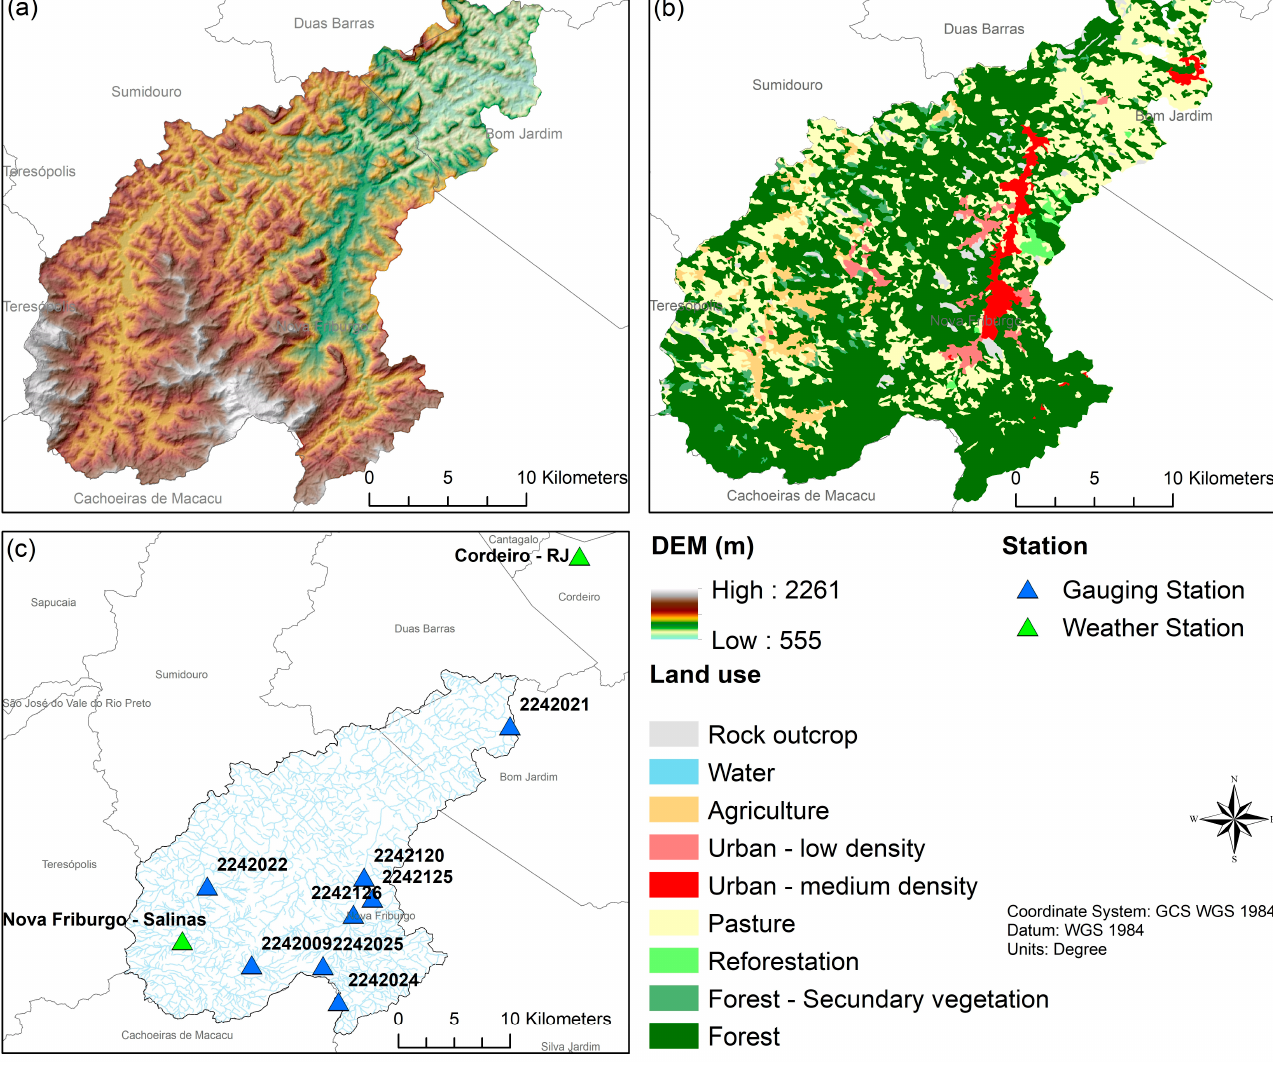
Figure 6. ( a ) Digital elevation model of the upper Rio Grande Basin. Source: Reprinted/adapted with permission from Ref. [28] 2013. NASA. ( b ) Land Use and Land Cover map of the Rio Grande Basin, RJ. Source: Reprinted/adapted with permission from Ref. [31] 2018. INEA. ( c ) Location of the pluviometric posts and climate stations of the upper Rio Grande Basin, RJ. Table 1. Rainfall